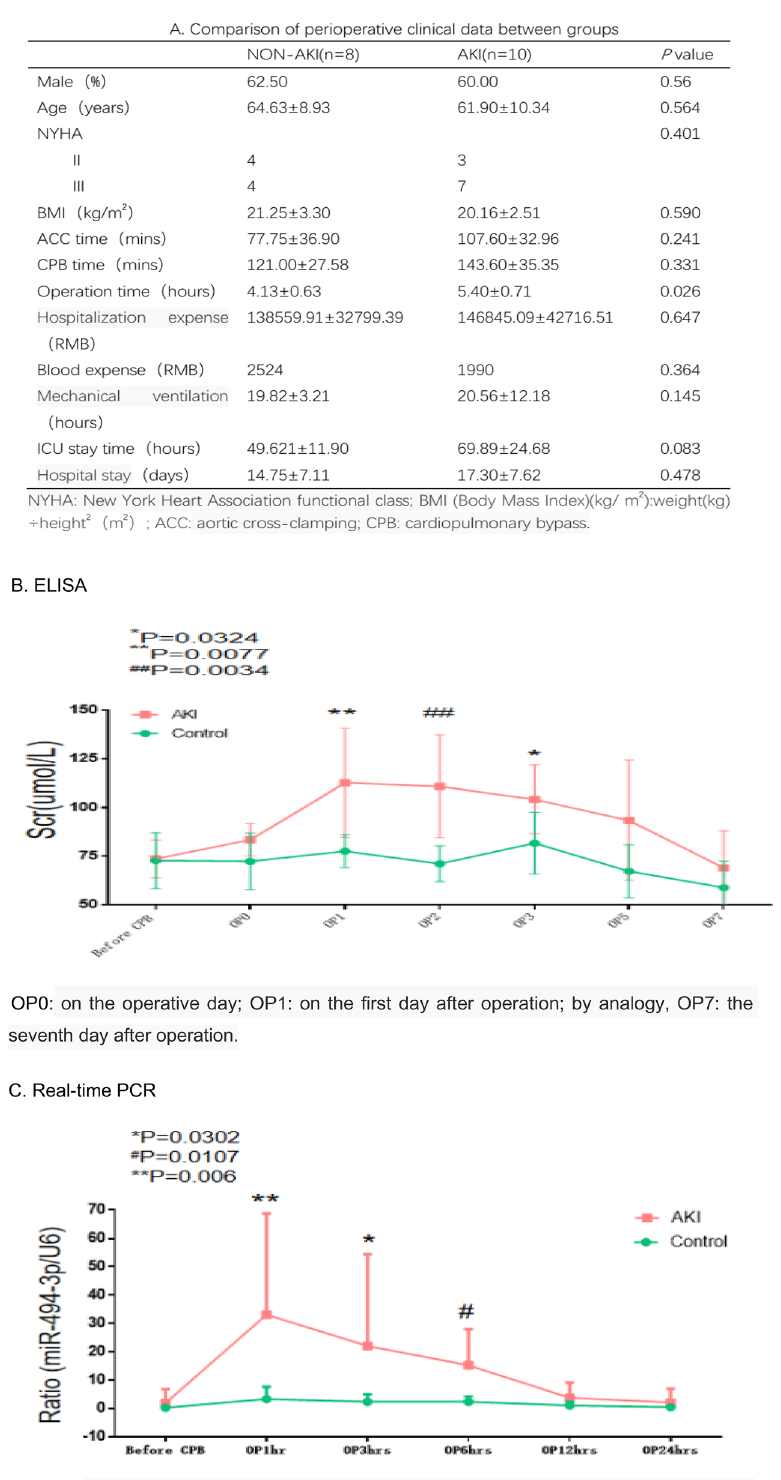
Figure 1. Comparison of perioperative clinical data, serum creatinine and hsa-miR-494-3p between two groups with cardiopulmonary bypass. ( A ) Comparison of perioperative clinical data between groups; ( B ) According to KDIGO standard, Elisa data show the difference of serum creatinine (SCr) between two groups after cardiopulmonary bypass; ( C ) Real-time PCR show the difference of serum hsa-miR-494-3p between two groups after cardiopulmonary bypass in a time-dependent manner. N (the replicate for ELISA and Real-time PCR) = 3. Data represent the mean ± SEM. *P < 0.05, **P < 0.01 versus